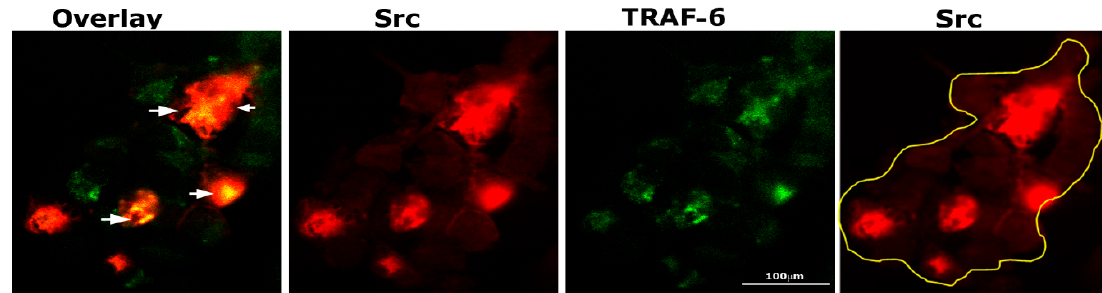
Figure 3. Immunostaining and confocal analyses of Src (red) and TRAF-6 (green) localization in osteoclasts plated on dentine slices and treated with TNF- α for 2–3 h Colocalization is indicated by arrows in overlay panels. The osteoclast is outlined with a yellow line in the Src (red) panel. The experiment was repeated twice, and similar results were obtained. Scale bar: 100 µm.